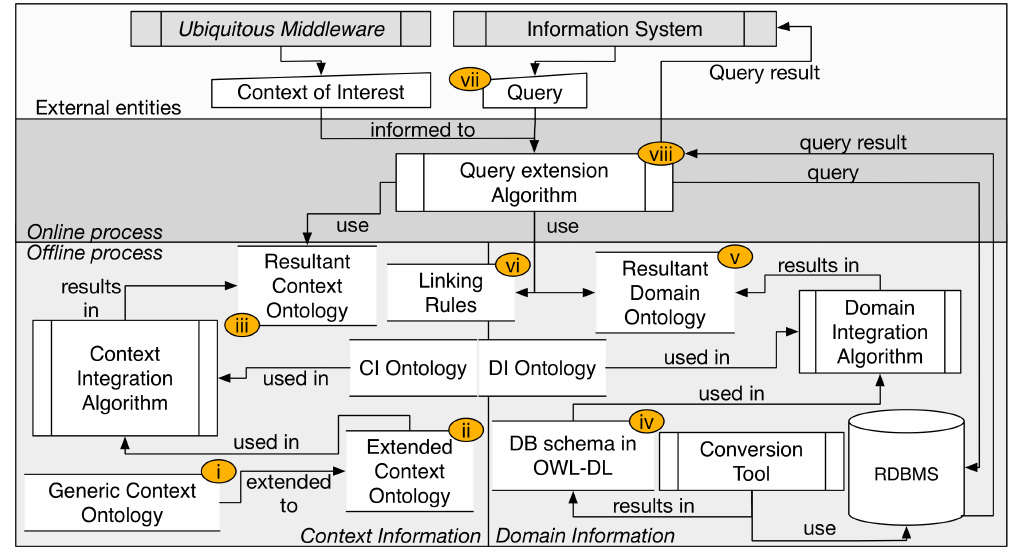
Figure 1. Components of the Context-Aware Retrieval (CAR) Model. Adapted from